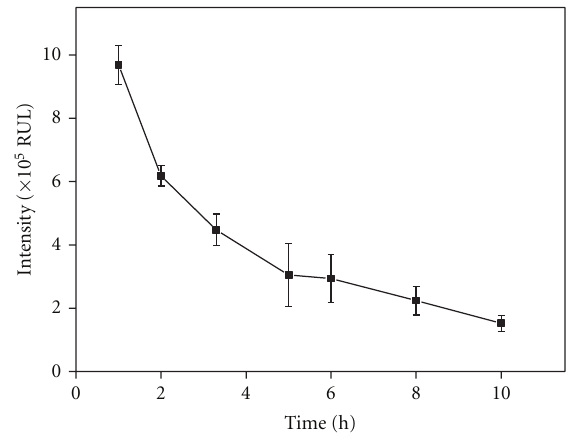
Figure 5: Stability of the POMs in deionized water. POMs: 2.5mg/mL, H 2 O 2 : 0.2 μ M, OV = −